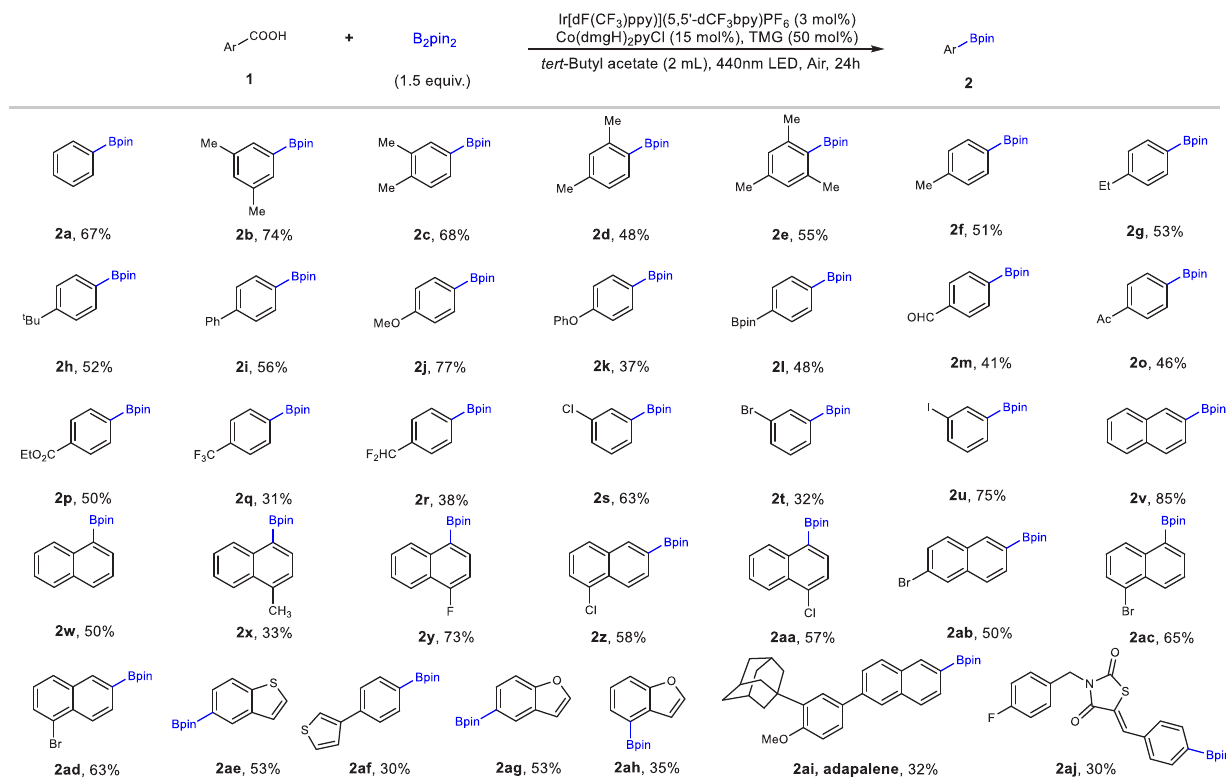
Fig. 2| Substratescope. Standardconditions: 1n (0.1mmol),B 2 pin 2 (1.5eq), [Ir-1] (3mol%), [Co-1] (15mol%),TMG (50mol%), tert -Butylacetate (2mL),440nm LED,24h. Isolated yield of products. TMG, N, N ’